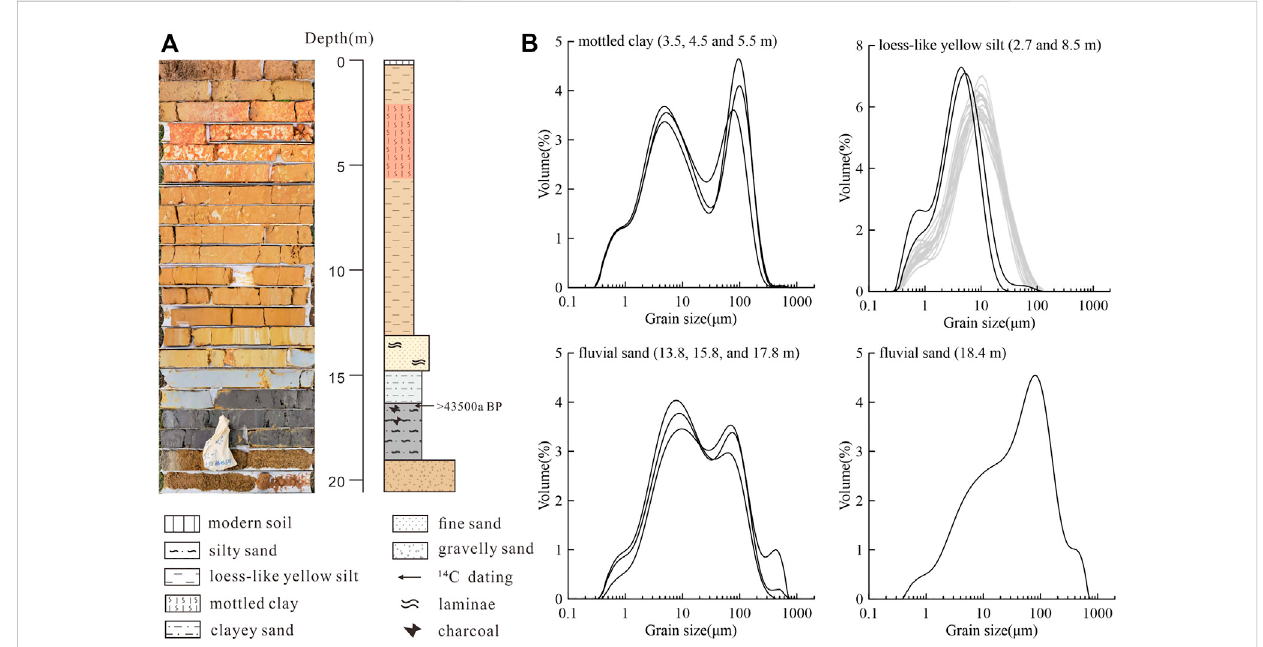
Lithology and grain size distribution of core HZ-ZK06. (A) Photography and lithology of core HZ-ZK06. (B) Grain size frequency distribution of differentlithological layersfromcoreHZ-ZK06.Thefrequencydistributionofloess-like yellowsiltinthePearlRiverDeltaisalsoshown(greylines)(Wang et al.,